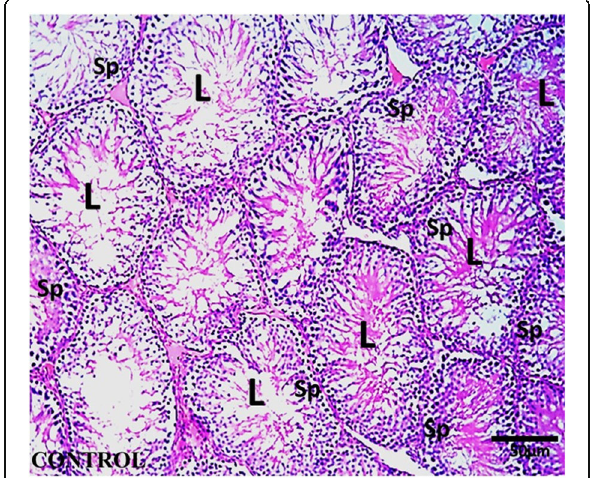
Fig. 13 Representative micrograph from the Nicotine group. Observe the irregularly shaped tubules with their atrophied germinal epithelium (arrows). The lumina is wide and depleted of spermatozoa (stars). The interstitial arteries are enlarged and congested with blood (block arrows). Stain: H&E; Scalebar: 50 μ m